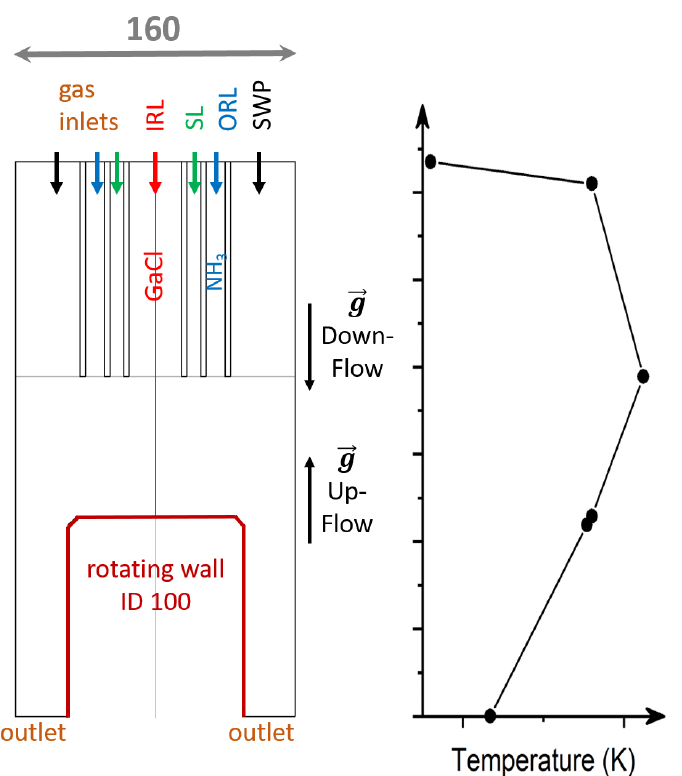
Figure 1. Sketch of the vertical HVPE reactor with indicated down-flow and up-flow configurations as well as the temperature distribution at the walls inside the reactor. The inner diameter (ID) of the rotation wall and the diameter of the complete reactor are given, in